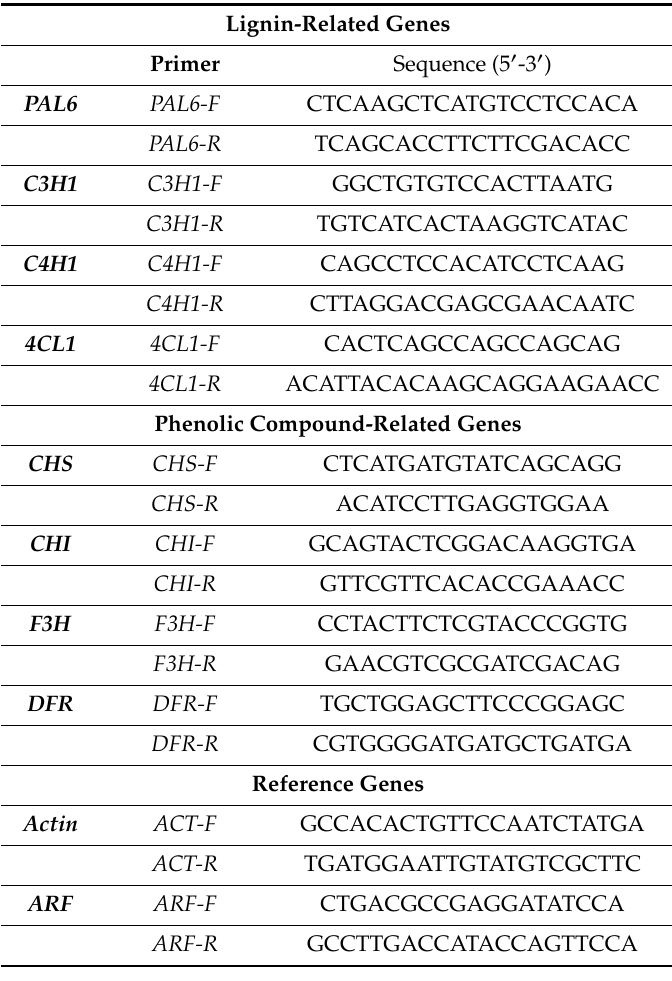
Table 1. Lists of genes and primers for qRT-PCR